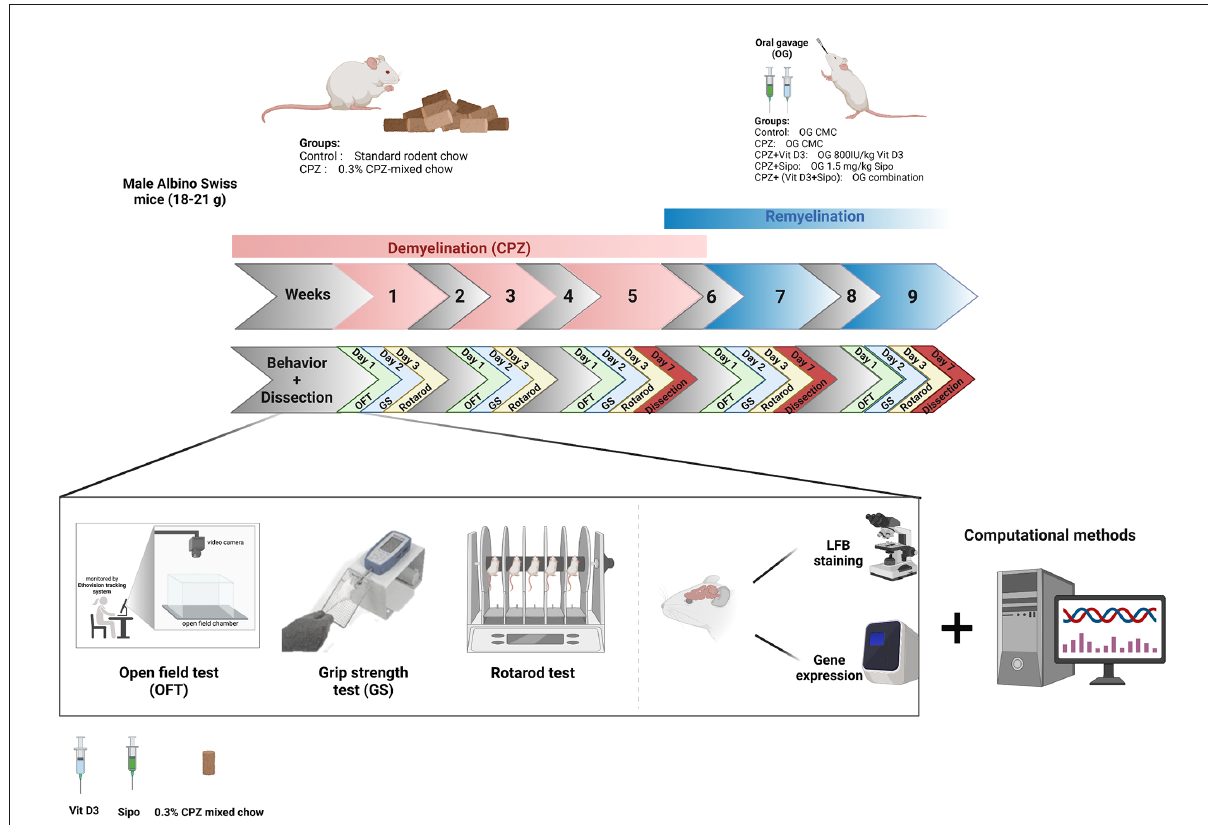
FIGURE1 Timeline of the study and experimental design. CPZ, cuprizone; CMC, carboxymethyl cellulose; Vit D3, vitamin D3; Sipo, siponimod; OFT, open field test; GS, grip strength; LFB, Luxol fast blue. Created with